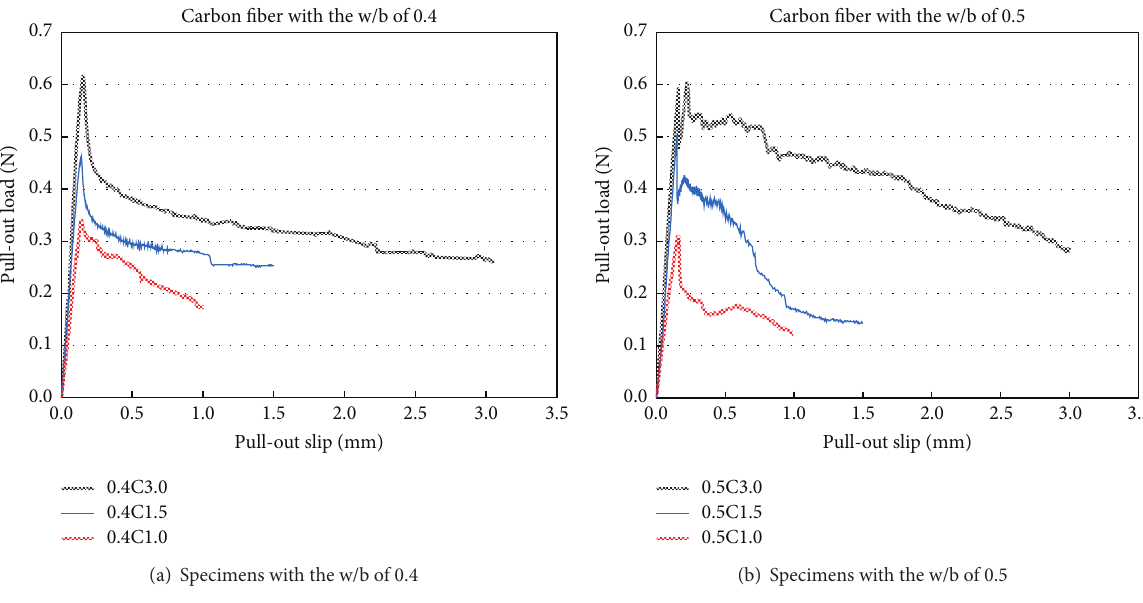
Figure 5: Pull-out load versus slip at the ends for specimens with carbon